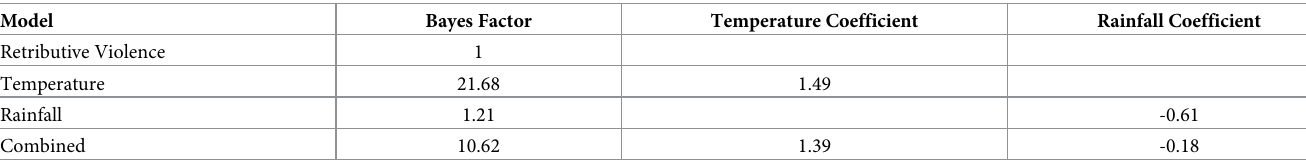
Table 1. Model results. Rows represent the primary results of a single